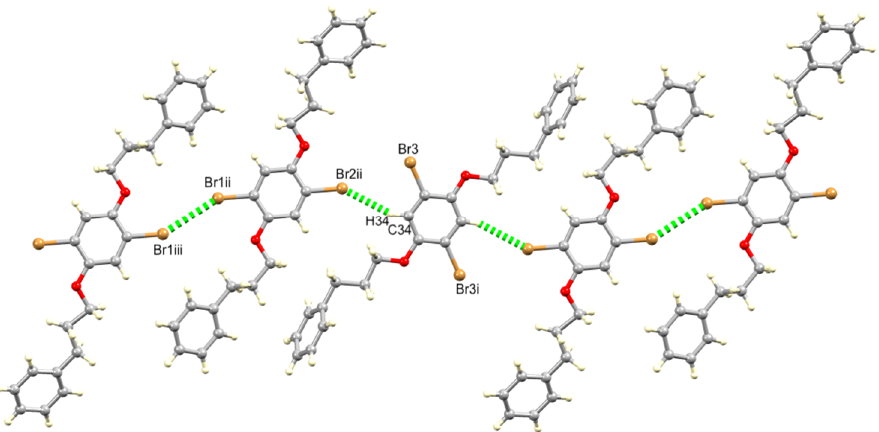
Figure 5. Alternating crystallographically independent molecules of 2 are associated into ribbons